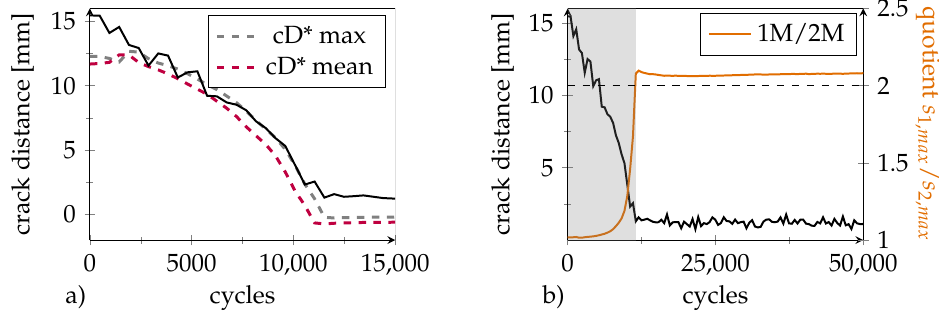
Figure 16. ( a ) Optically measured remaining crack distance from the DSF (black) and crack distance (cD*) estimated from the signal ratios of sensor 1M and 2M at two different load levels ( s max and s mean ). ( b ) Course of s 1, max / s 2, max (orange) with progressing crack. Grey area marks region of continuous crack progression. Initially the ratio assumes a value of 1 but increases with crack propagation. As soon as the crack reaches the first DSF, the ratio assumes a value of 2 and optical evaluation (black) reveals that the crack has